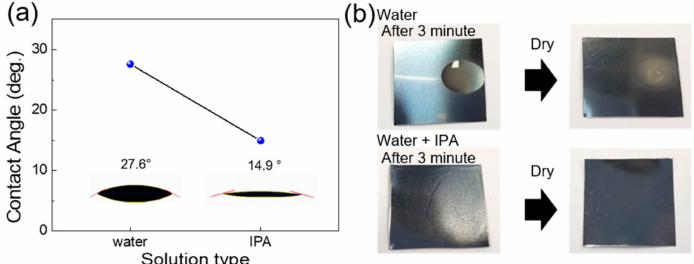
Figure 2. ( a ) Contact angle of brush painted Ag NW network coated on SiO 2 / invar substrate using water-based and isopropyl alcohol (IPA)-based Ag NW ink. ( b ) Pictures showing e ff ect of solvent in Ag NW ink. After brushing painting, the Ag NW network showed a di ff erent uniformity depending on water solvent (top) and IPA + water solvent (bottom).